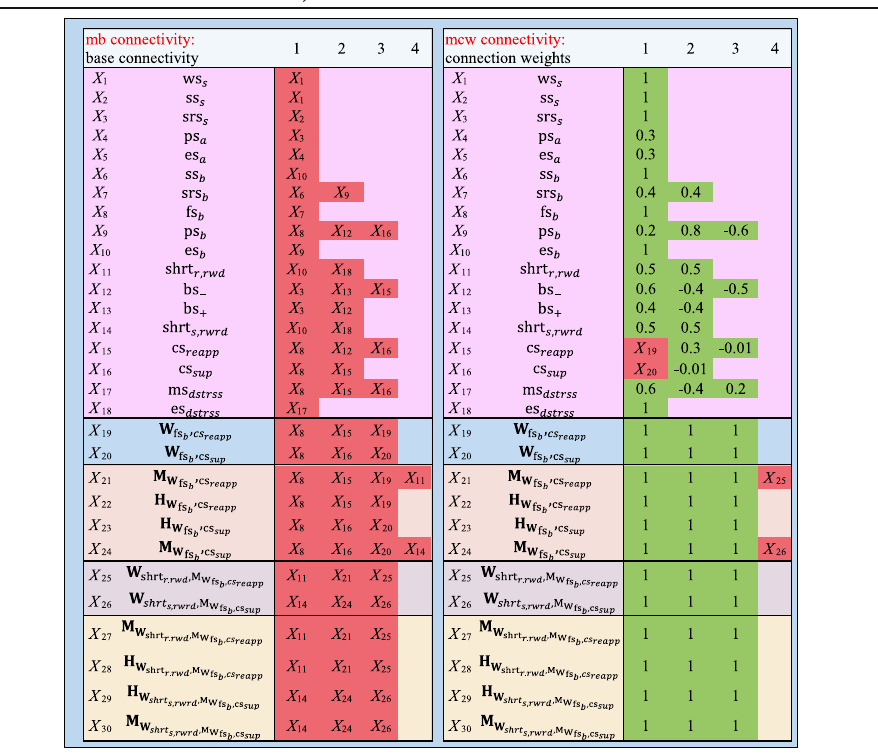
Box 1 Role matrices for